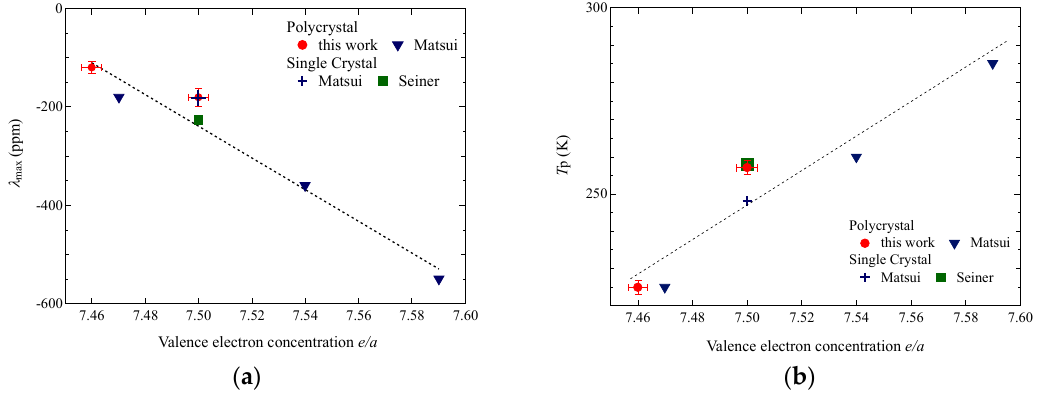
Figure 8. ( a ) The valence electron e / a dependence of peak value of the magnetostriction around the premartensite temperature T P ; ( b ) The valence electron e / a dependence of the T P . Filled circles: this work. Filled triangles: polycrystal, Matsui et al. [26,40]. Cross: single, Matsui et al. [40]. Filled square: single, Seiner et al. [17]. Dotted lines are fitting lines. The error bars in this work were indicated.